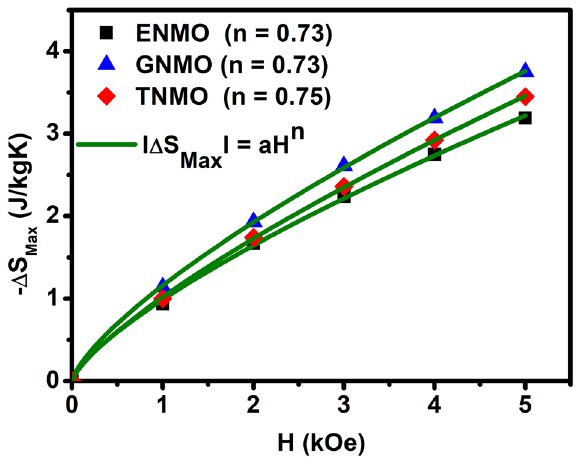
Figure 7. |ΔS Max | data of ENMO, GNMO, and TNMO samples fitted to a function | △ S Max |= α × H n , where the values of exponent “n” are labelled in the